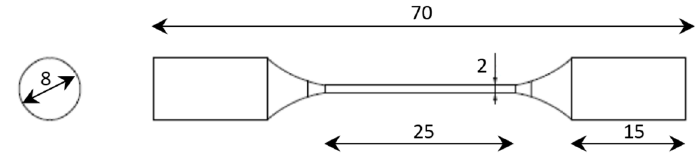
Figure 1. Beam specimen geometry (dimensions in mm).